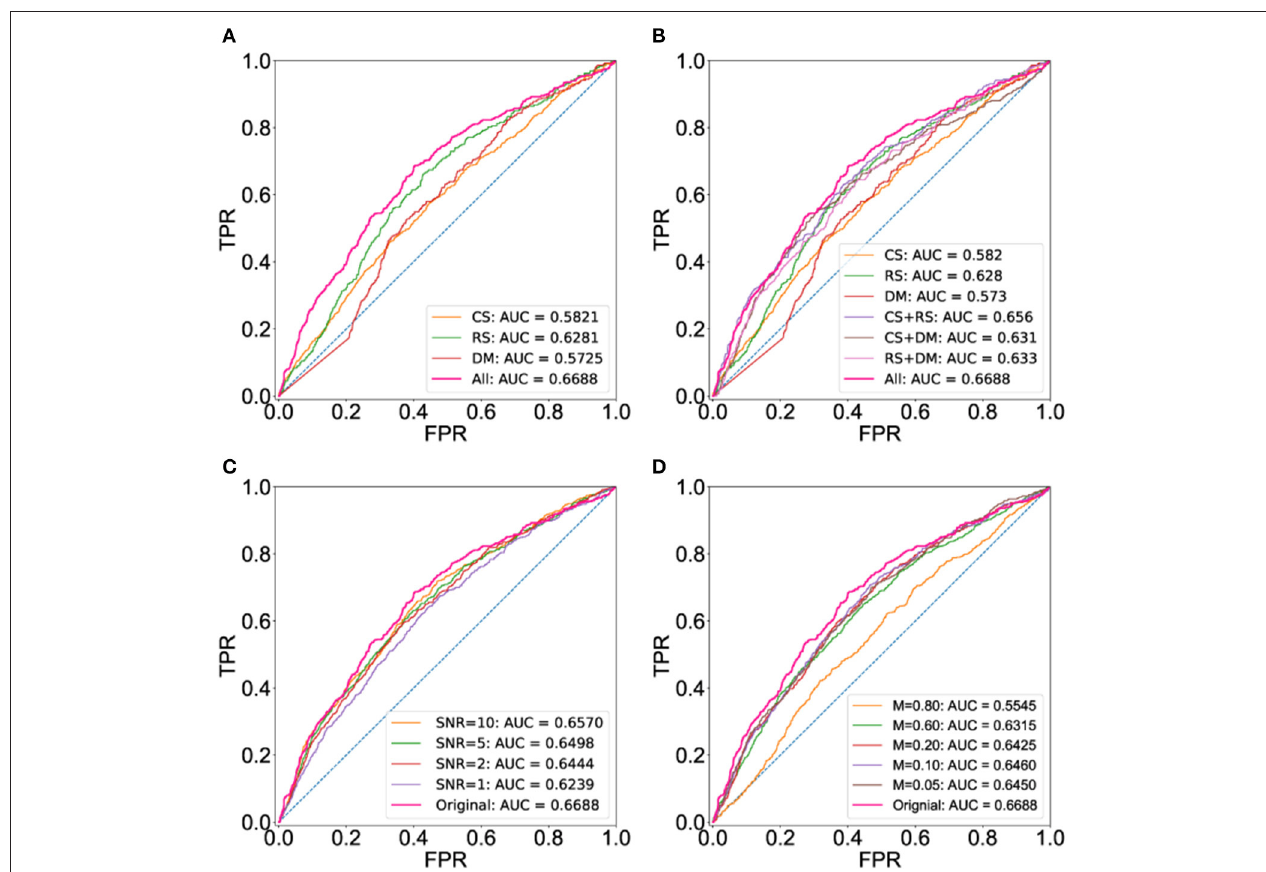
FIGURE 2 | ROC curves using the set of gold standard TF interactions based on physical protein-protein interactions. ROC curves are computed using a set of gold interactions from HumanNet, iRefIndex and a large-scale two hybrid mapping study. (A) ROC curves of the integrated and three individual networks. (B) ROC curves of the integrated networks, three individual ones and integrated ones with any two datasets. (C) ROC curves of integrated network with different levels of noise. (D) ROC curves of integrated network with different percentage of missing